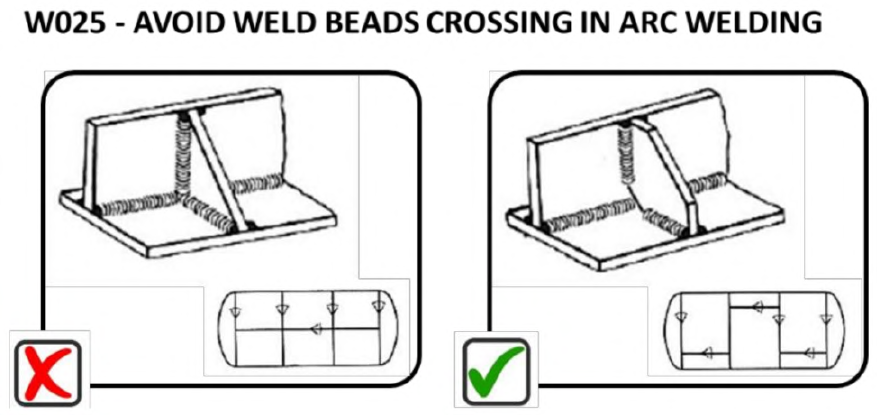
Figure 3. Example of W025 DFW guideline syntax and